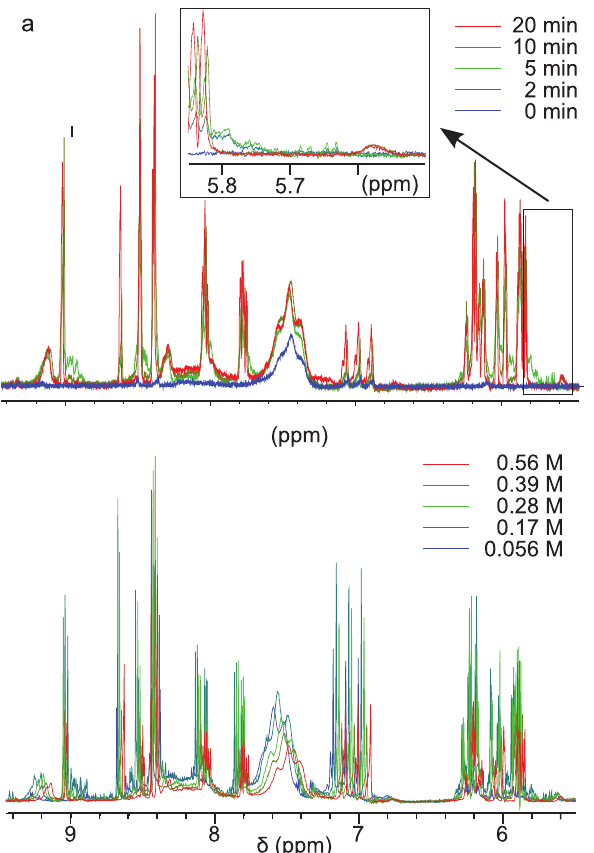
Fig 1. Comparison of the downfield part of NMR 1 H spectra of E . coli metabolites (upfield part in supplemental material), after 3 h incubation in Seine river water under room light, with different extraction protocols. (a) influence of boilingtime for cell lysis: no ebullition(deep blue) and 2 to 20 min ebullition(cyan to red) in a 0.56 M perchloric acid solution;(b) influence of perchloricacid concentration: 0.056 to 0.56 M (blue to red), with a boilingtime of 10 min. The arrow points out areas where decreasing intensity at long boilingtime is an indicatorof the degradationof some metabolites.